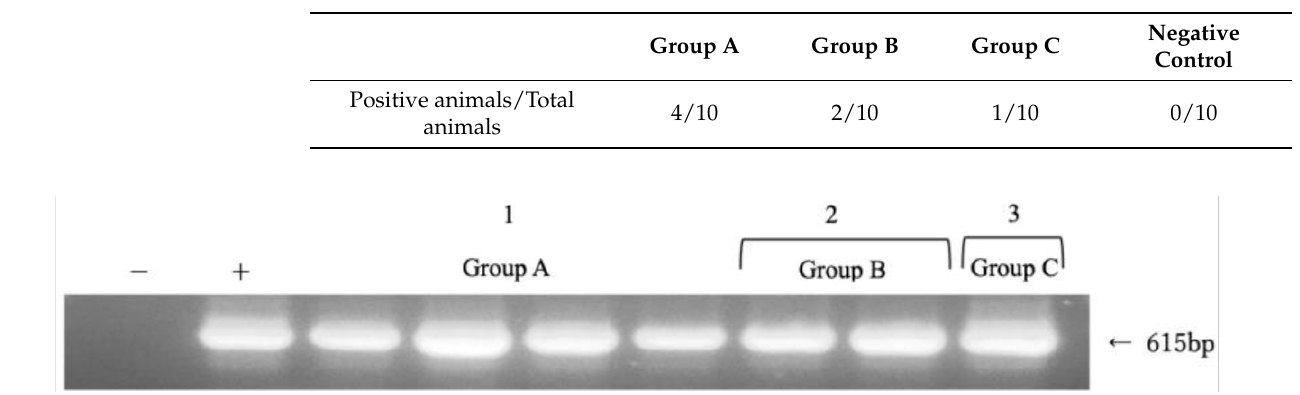
Table 1. Blood culture analysis.